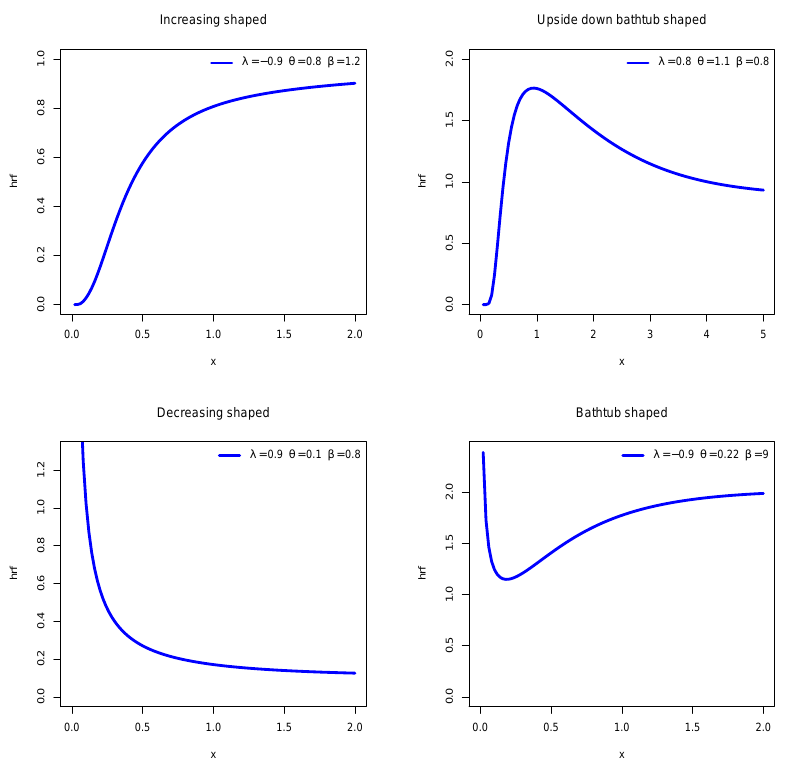
Figure 3. Individual plots of the hazard rate function (hrf) of the TOFrE distribution for the main observed